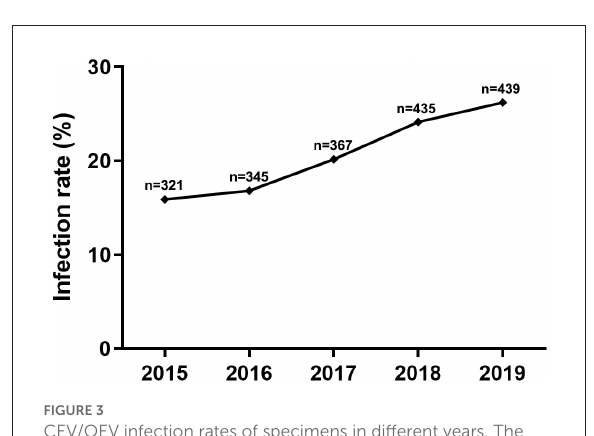
FIGURE3 CEV/OEV infection rates of specimens in different years. The node represents the CEV/OEV infection rate for corresponding year from 2015 to 2019. “n” represents the number of specimens